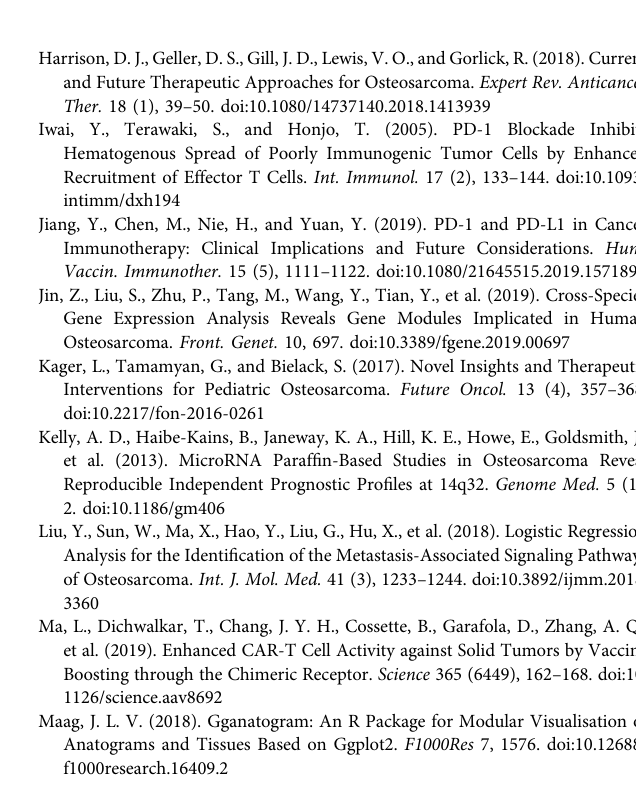
Supplementary Table S1 | The symbols and categories of 1793 IRGs. Supplementary Table S2 | The sequences of primer and siRNA oligonucleotides. Supplementary Table S3 | Differentially expressed